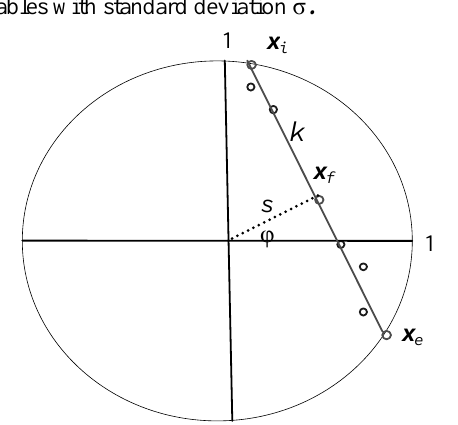
Fig 3 . Line segment in the unit circle with inliers. Point x f is closest to the origin. The inliers are uniformly distributed along the line segment between start and endpoint x i and x f